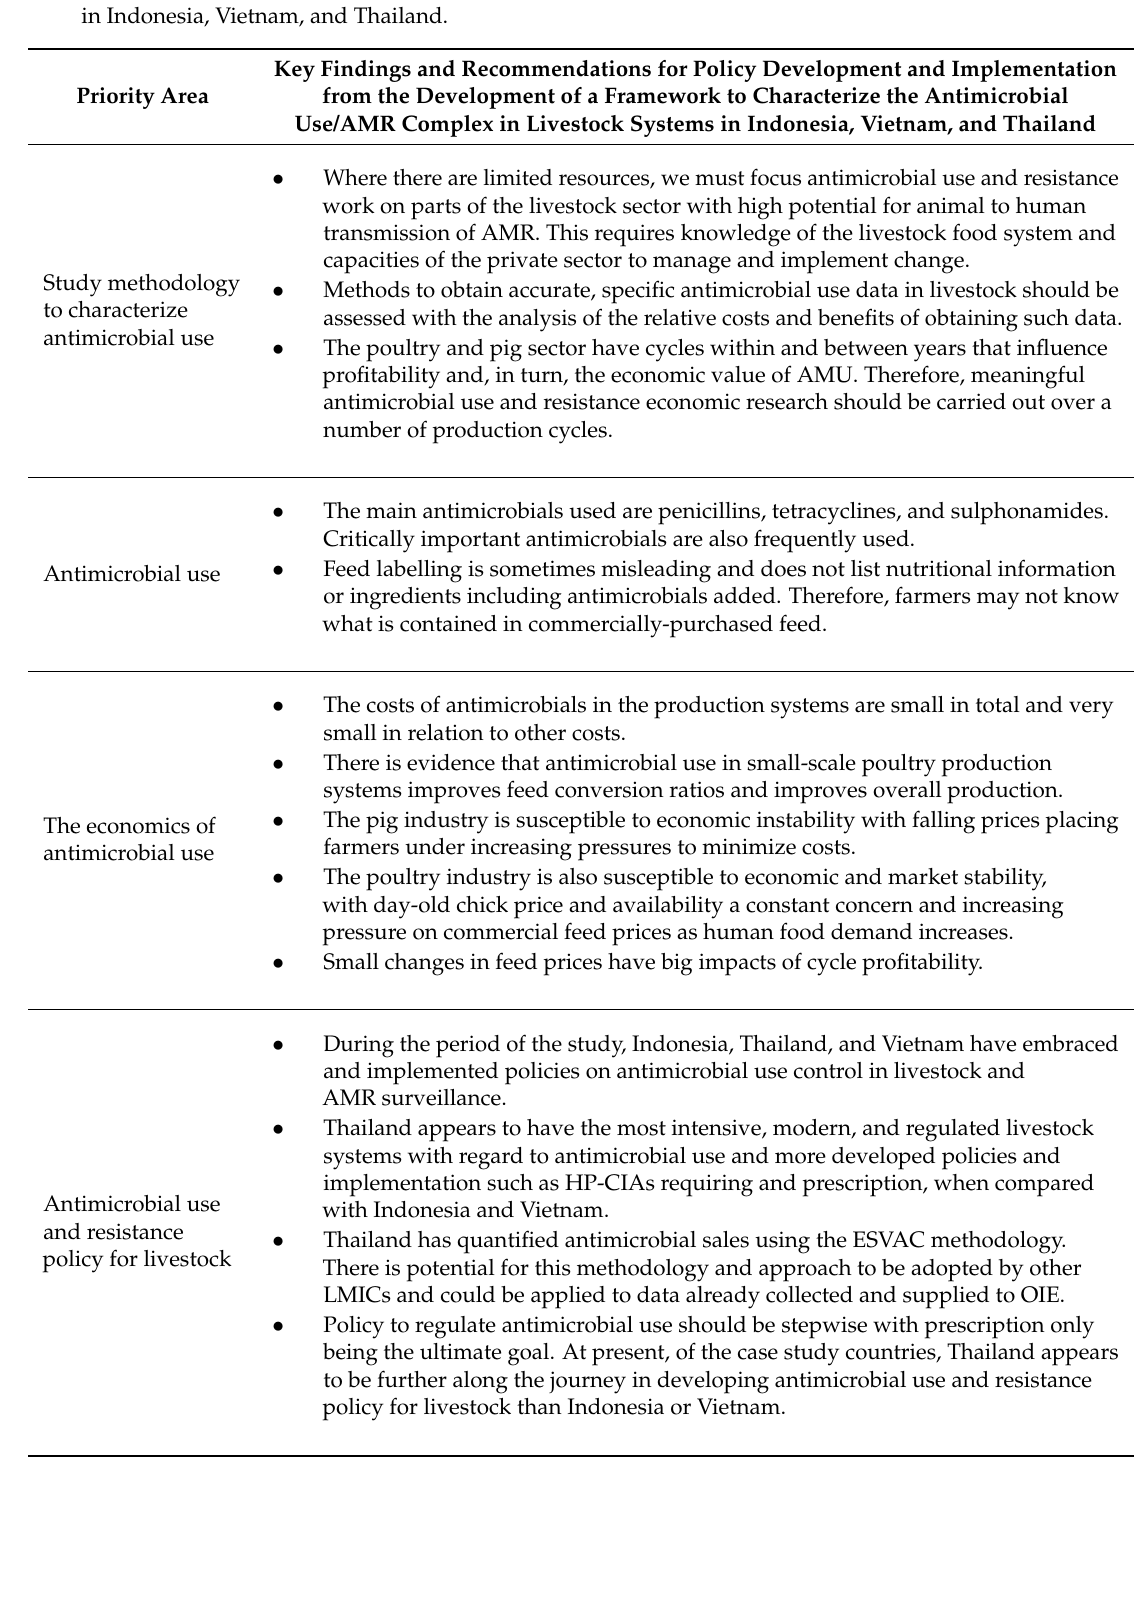
Table 10. Key findings and recommendations for policy development and implementation from the development of a framework to characterize the antimicrobial use/AMR complex in livestock systems in Indonesia, Vietnam, and